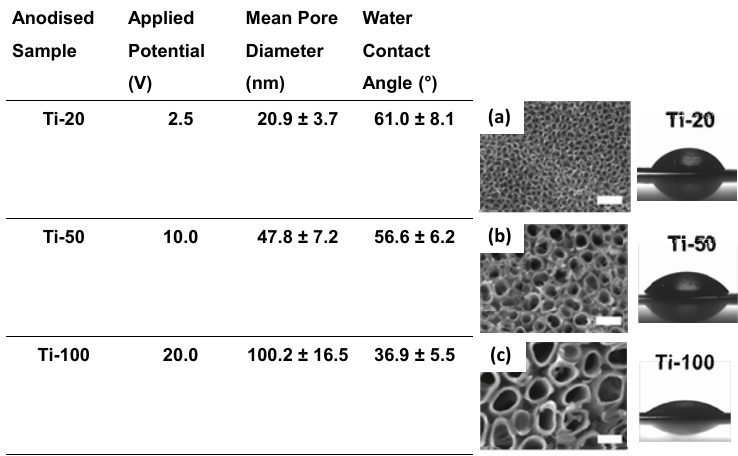
Figure 2. ( a ) AlamarBlue TM metabolic activity of human mesenchymal stem cells (hMSCs) cultured on anodised titanium samples with respective pore diameter at Day 7 and 14 in growth medium (GM) and osteogenic medium (OM). Values are mean ± S.D., n = 4, *p < 0.05; ( b – j ) LIVE/DEAD cell viability